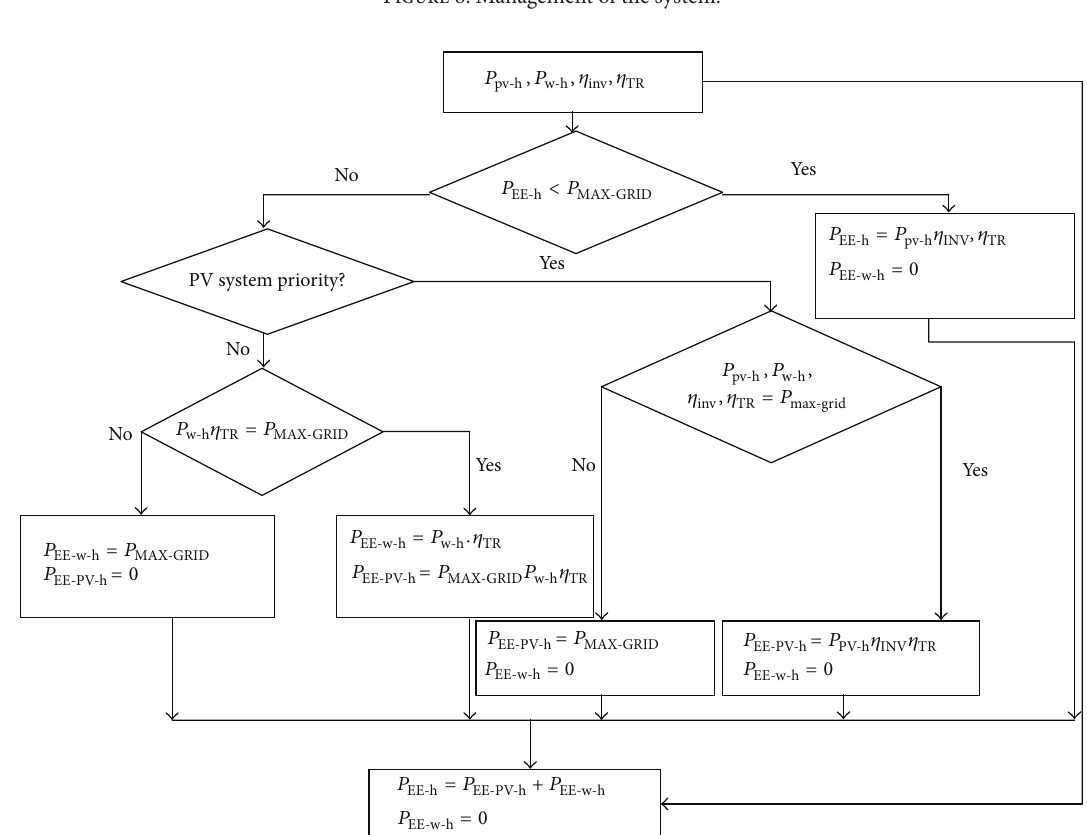
Figure 8: Management of the system.